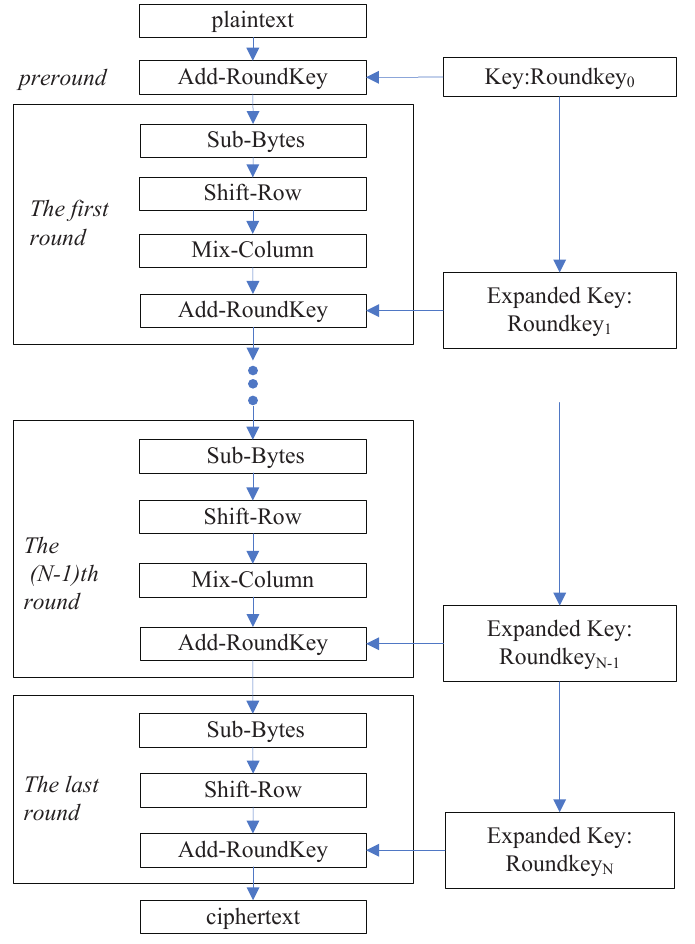
Figure 2. The flow of encryption of AES